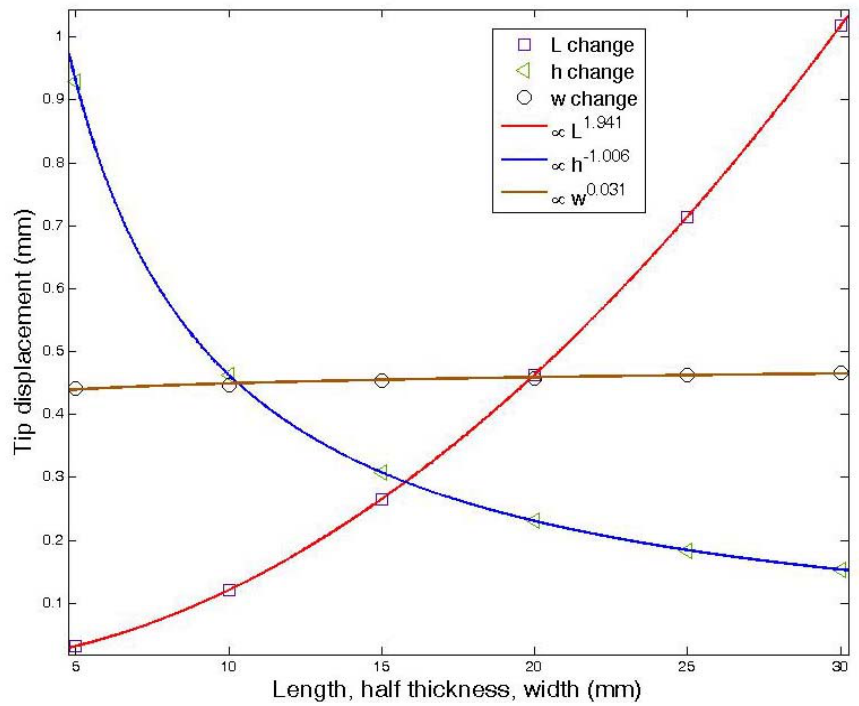
Figure 4. The schematic diagram of the geometry parameters of a cantilever beam shaped IPMC and the tip